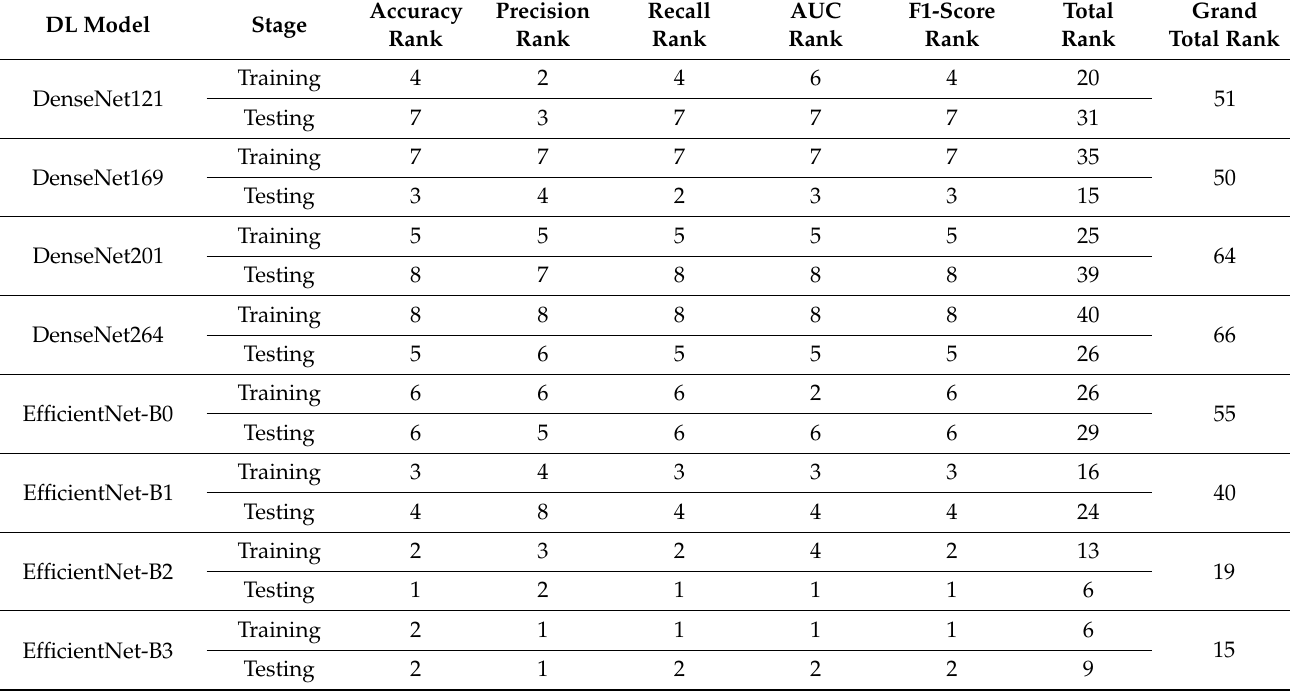
Table 11. The acquired rankings of all DL model performance indices for AD vs. sMCI classification.